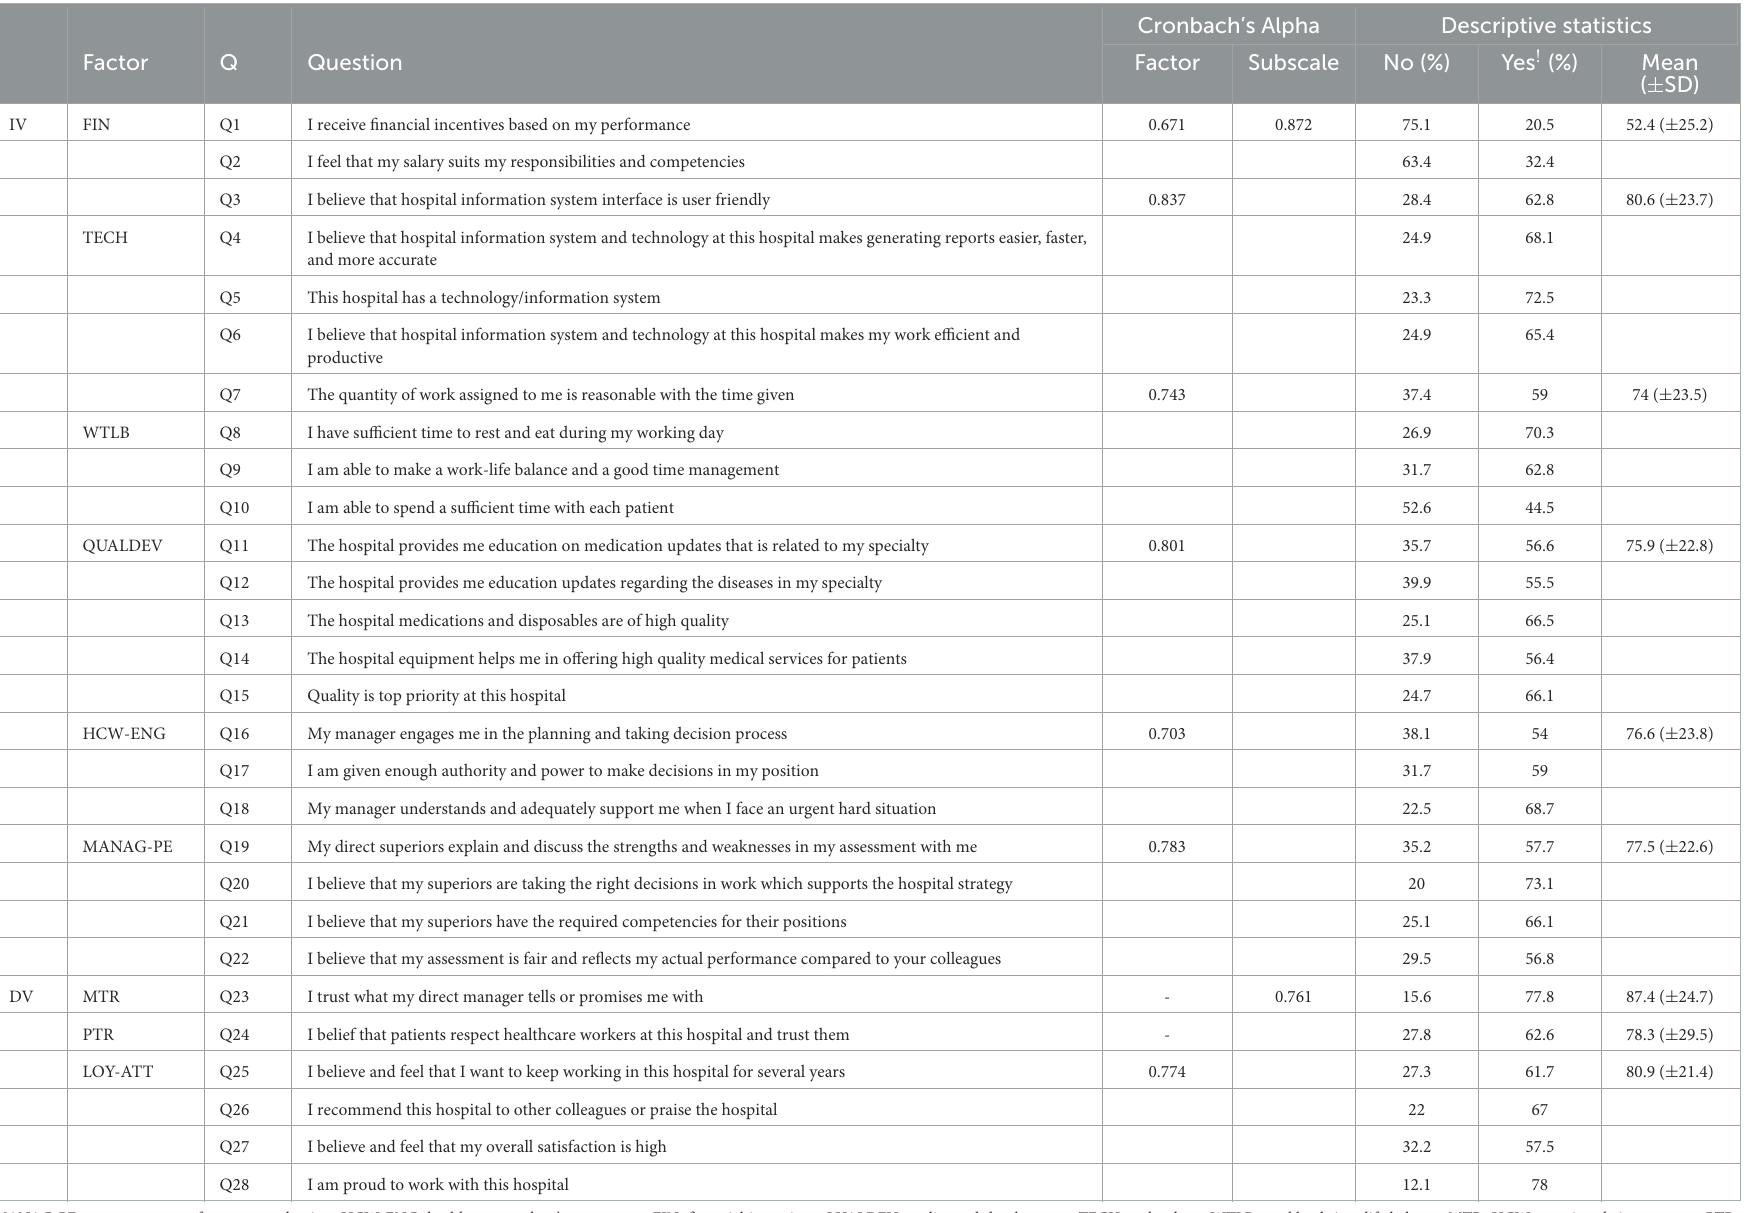
TABLE 2 Descriptive statistics of factors and underlying questions (N =